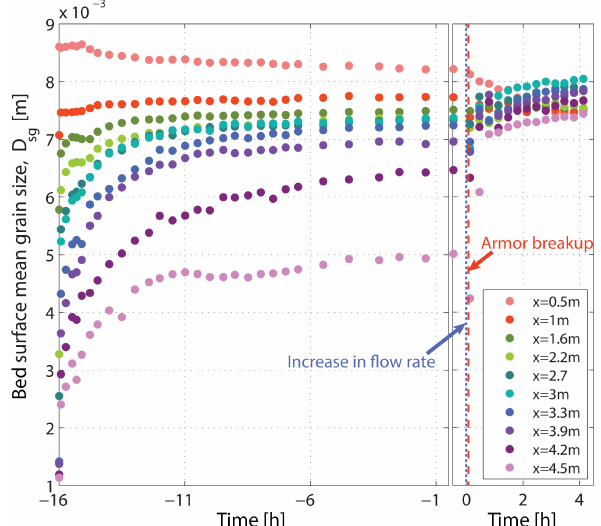
Figure 10. Measured change in the geometric mean grain size of the bed surface sediment at various locations in Experiments T 1 and T 2 . The blue dotted line indicates the moment of the increase in flow rate ( t = 0h) and the red dashed line indicates the moment of armor breakup ( t =